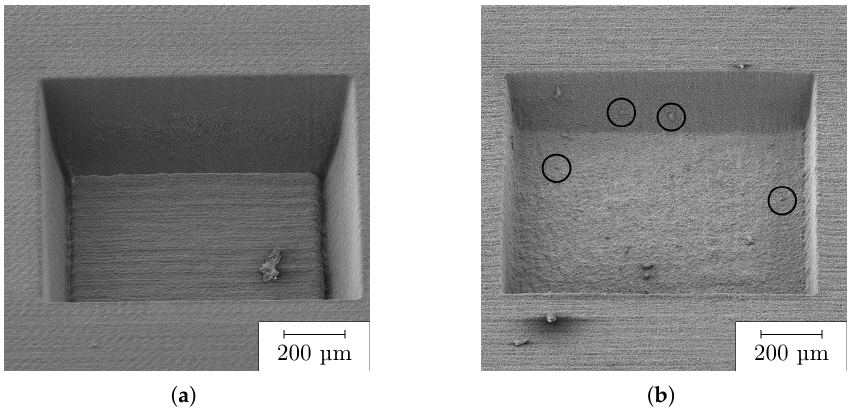
Figure 8. A 45°-tilted SEM image of ablation cavities on COC with different wavelengths: ( a ) UV; ( b ) IR under same conditions at a fluence of 10.5Jcm − 2 (circles show reattached